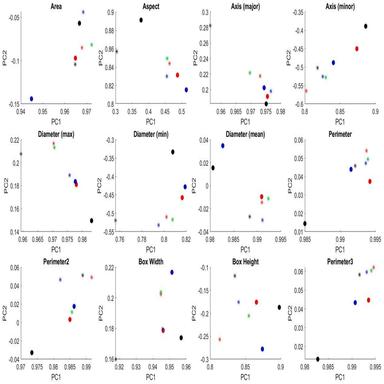
Enlarged loadings plots - morphology parameters in time. Circles represent the characteristic time of 24, 36 and 42 min of the material's cavitation erosion.